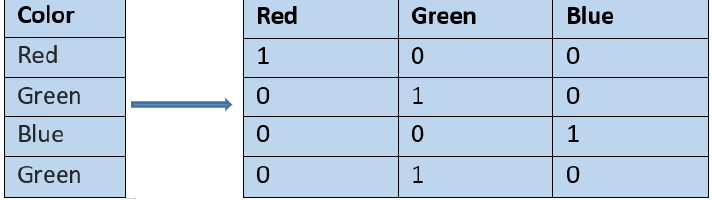
Figure 1. An example of one-hot